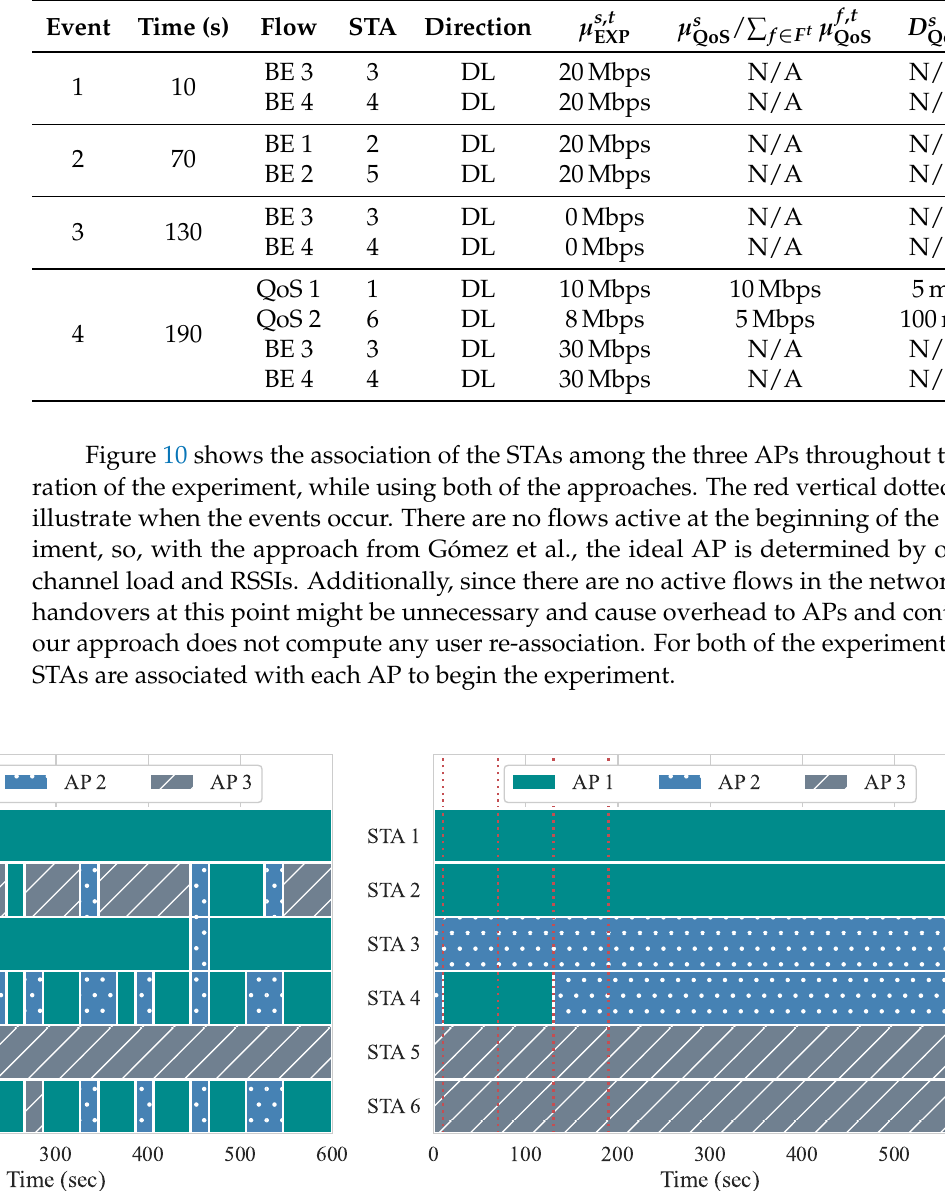
Table 6. Workload parameters used in experiment 2.